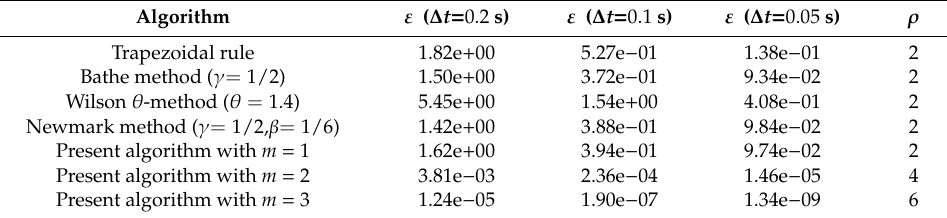
Table 2. Errors of velocity solutions (pendulum) calculated from different algorithms.